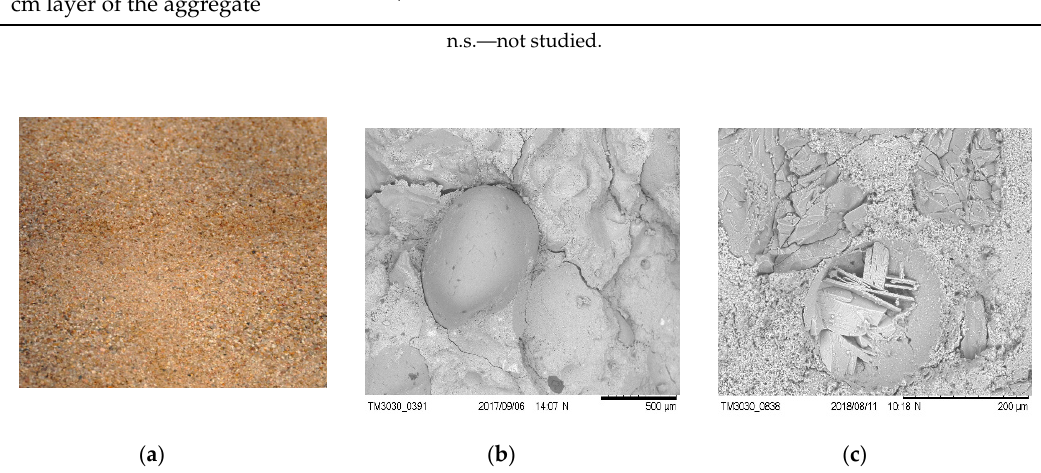
Figure 3. Aggregate NATU ( a ) grains to 4 mm; ( b ) grain surface, 100×; ( c ) grain structure after cutting the sample (grain in the vicinity of cement paste), 1000×.